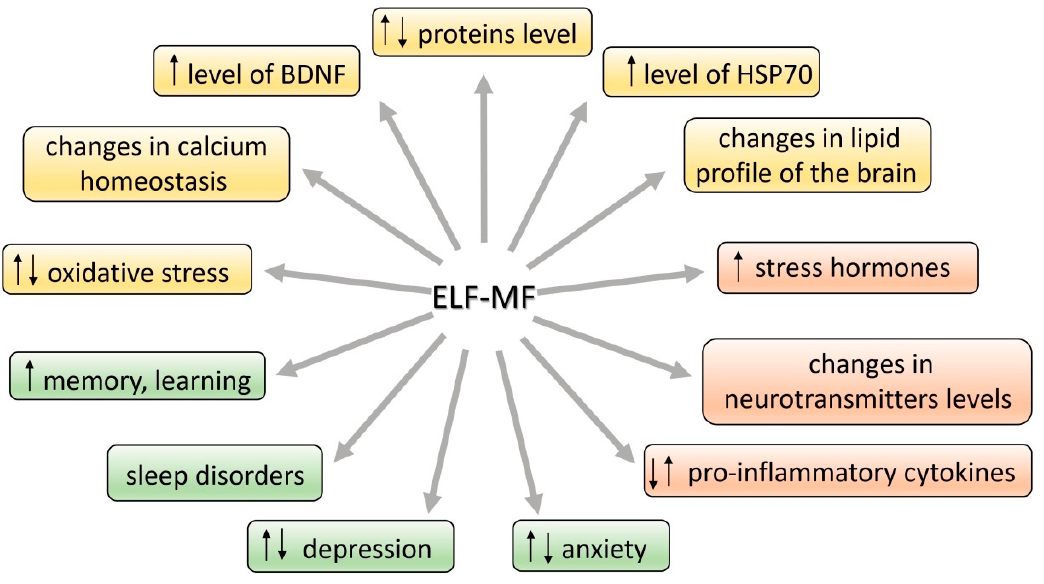
Figure 1. Effects of extremely low-frequency magnetic field (ELF-MF) action in the organism .